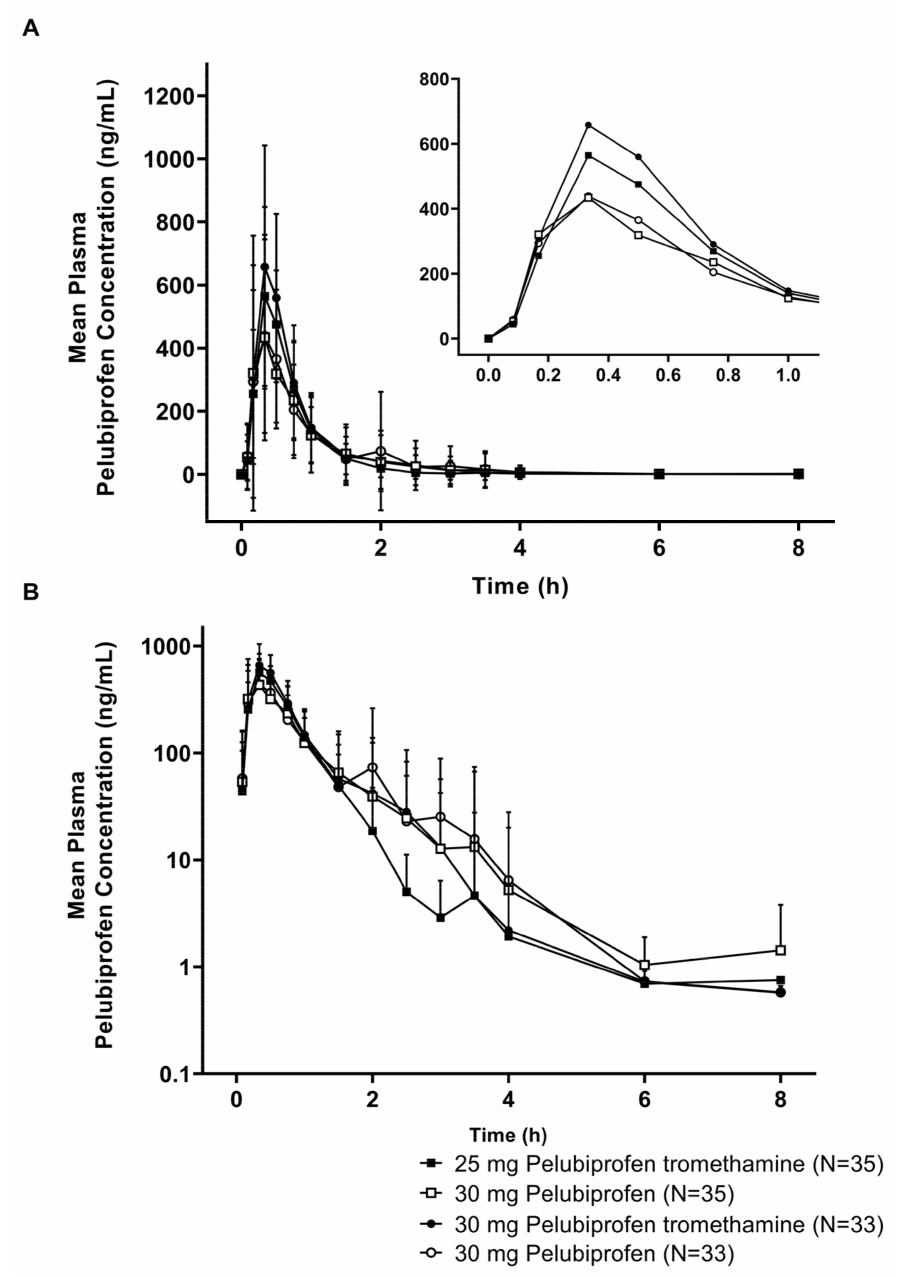
Figure 2. Mean plasma pelubiprofen concentration vs. time profiles after a single oral administration of 25 mg of pelubiprofen tromethamine (N = 35) or 30 mg of pelubiprofen (N = 35) in Study I and 30 mg of pelubiprofen tromethamine (N = 33) or 30 mg of pelubiprofen (N = 33) in Study II. The upper ( A ) and lower ( B ) panels are shown in linear (mean ± standard deviations) and semi-logarithmic (mean + standard deviation) scales, respectively. The figure inset within Figure 2 shows the mean plasma pelubiprofen concentration from time 0 to 1 h after